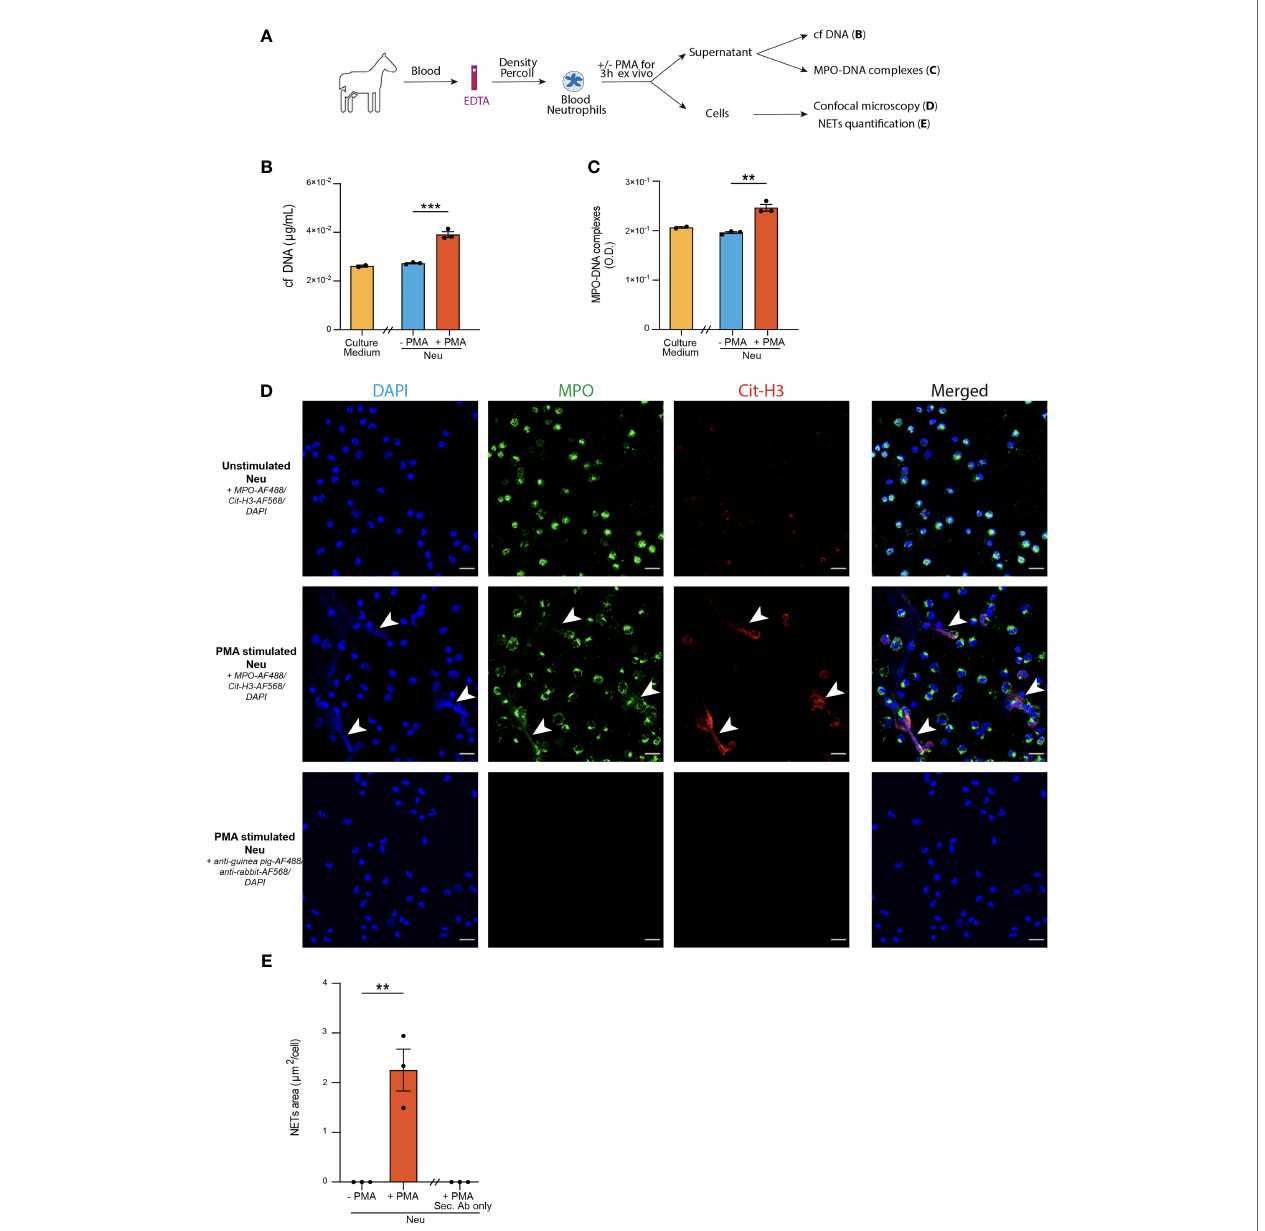
FIGURE 1 | Optimization of three distinct methods to detect NETs release from blood neutrophils in horses. (A) Experimental Outline. Horse blood neutrophils were isolated by density gradient and cultured for 3 hours without (negative controls, Neu -PMA) or with (positive controls, Neu +PMA) PMA. Cell culture supernatants were recovered to measure cf DNA and MPO-DNA complexes, and cells were analyzed by confocal microscopy. (B) Cf DNA content in culture supernatants evaluated by PicoGreen assay. (C) MPO-DNA complexes measured in culture supernatants by ELISA. (D) Representative confocal microscopy pictures (objective 20x) of blood neutrophils in the indicated conditions. NETs are de fi ned as extracellular structures double positive for MPO and Cit-H3 and are indicated by white arrows. (E) NETs quanti fi cation in culture slides expressed as extracellular areas positive for MPO and Cit-H3. (B, C, E) Data show mean +/- s.e.m, and individual values from 3 independent experiments. Each symbol represents the mean of one independent experiment. P values were estimated with a two-tailed unpaired Student t -test. **, P < 0.01; ***, P < 0.001. Neu, neutrophils. Scale bar = 20